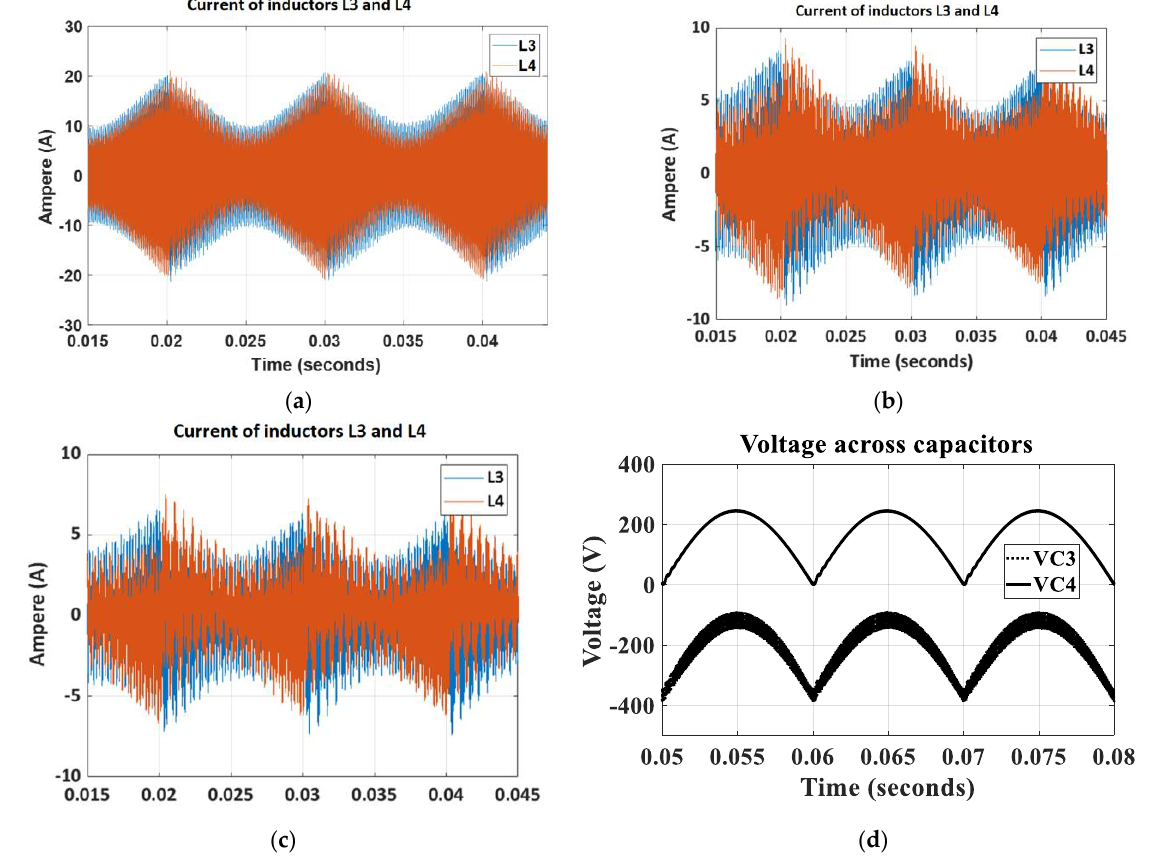
Figure 19. ( a – c ) Currents of inductors 𝑳 𝟑 and 𝑳 𝟒 ; ( d ) voltage waveforms across capacitors 𝑪 𝟑 − 𝑪 𝟐 in the proposed QZS converter.